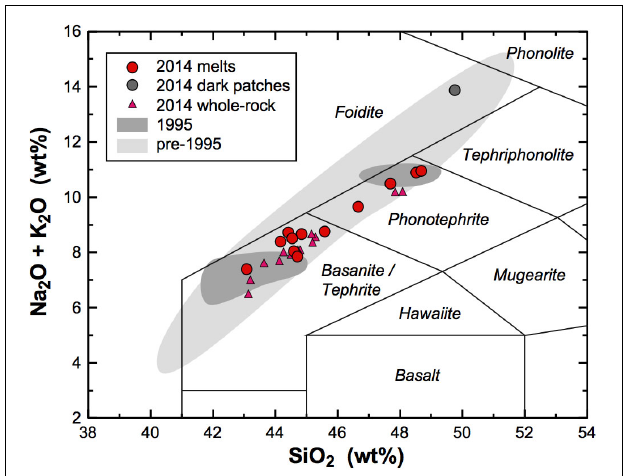
FIGURE 3 | Total alkalis versus silica (TAS) diagram with boundaries after LeMaitre et al. (1989), showing the groundmass compositions of the investigated samples. Whole-rock compositions from the 2014–2015 eruption are from Mata et al. (2017). The fields for whole-rock compositions from previous eruptions are based on data from Munhá et al. (1997), Kokfelt (1998), Doucelance et al. (2003), Escrig et al. (2005), and Hildner et al. (2011, 2012). All data are normalized to 100 wt.%